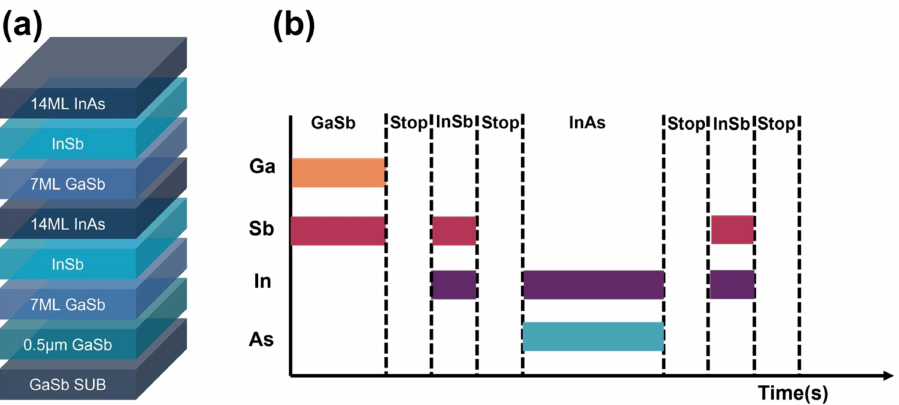
Figure 6. ( a ) Superlattice structure; ( b ) growth shutter